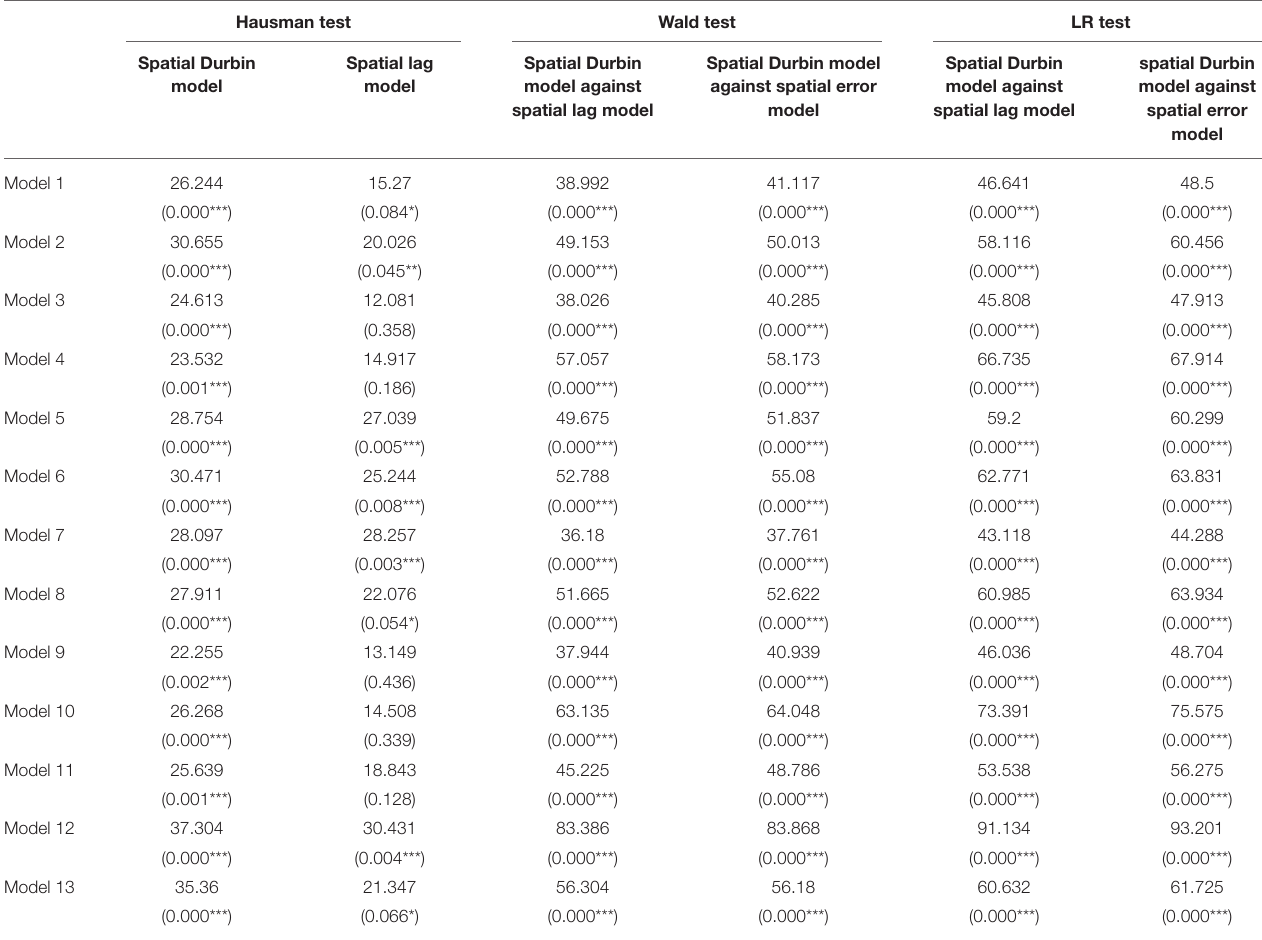
TABLE 4 | Spatial Durbin model and Hausman test